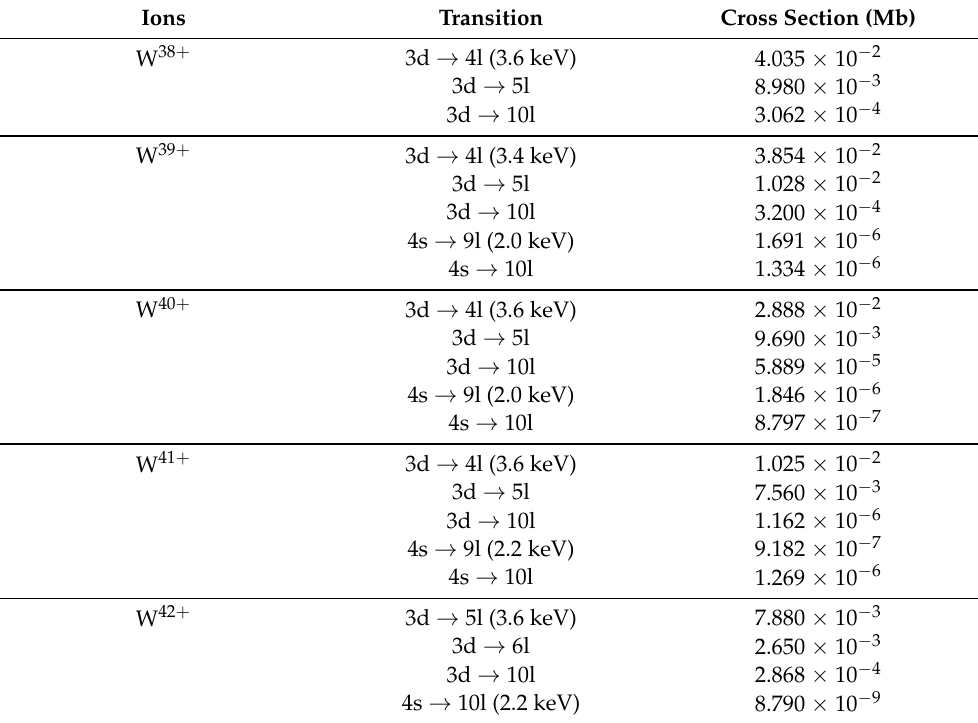
Figure 12. The total electron-impact single ionization cross-section for W 44 + , W 42 + − W 38 + . Dot curve: cross-sections of direct ionization. Red sold curve: cross-sections of total ionization with full branching (1.0 kb = 10 − 21 cm 2 ). Table 4. Selected threshold excitation cross-sections for W 38 + − W 45 + (1.0 Mb = 1.0 × 10 − 18 cm 2 ).